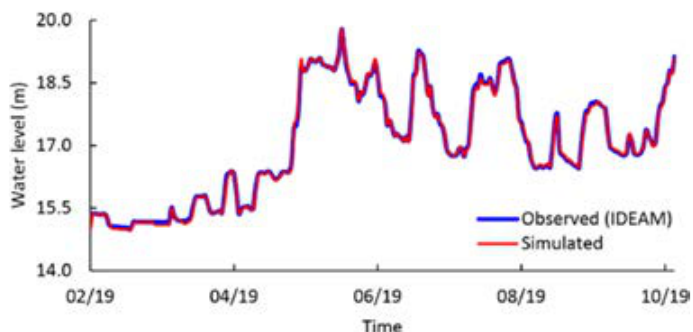
Fig. 4: Hydrodynamic component calibration